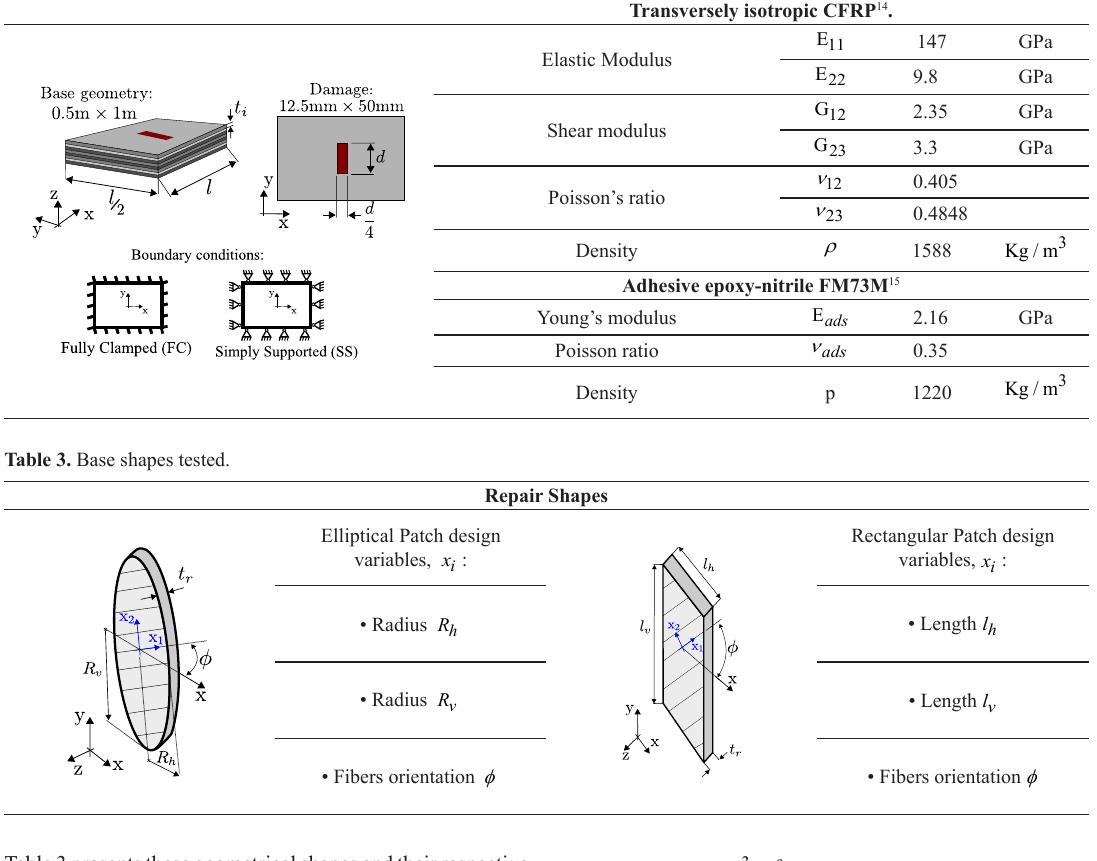
Transversely isotropic CFRP 14 .